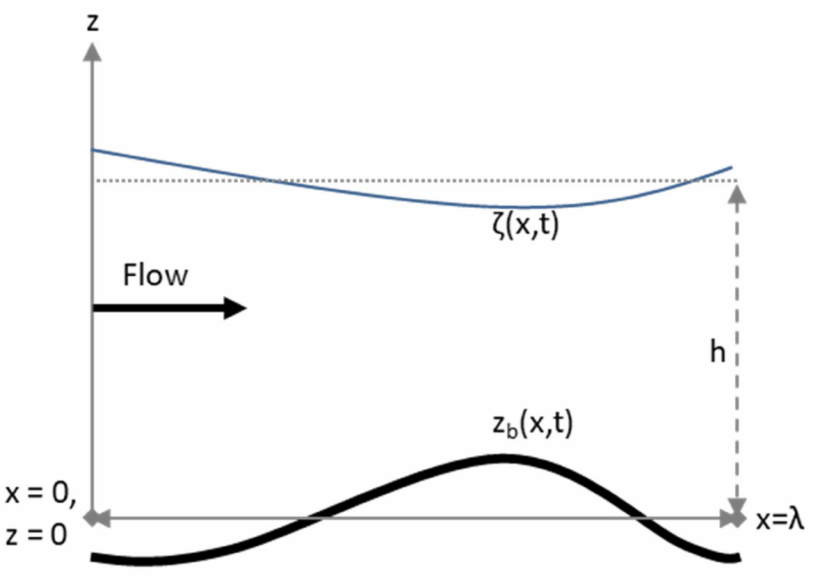
Figure 2. The computational